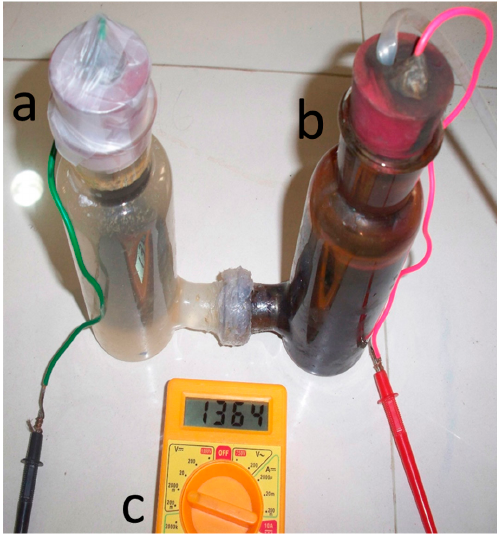
Fig. 2. Microbial fuel cell – double chambered fuel cell (with salt bridge) a) anode chamber, b) cathode chamber c)